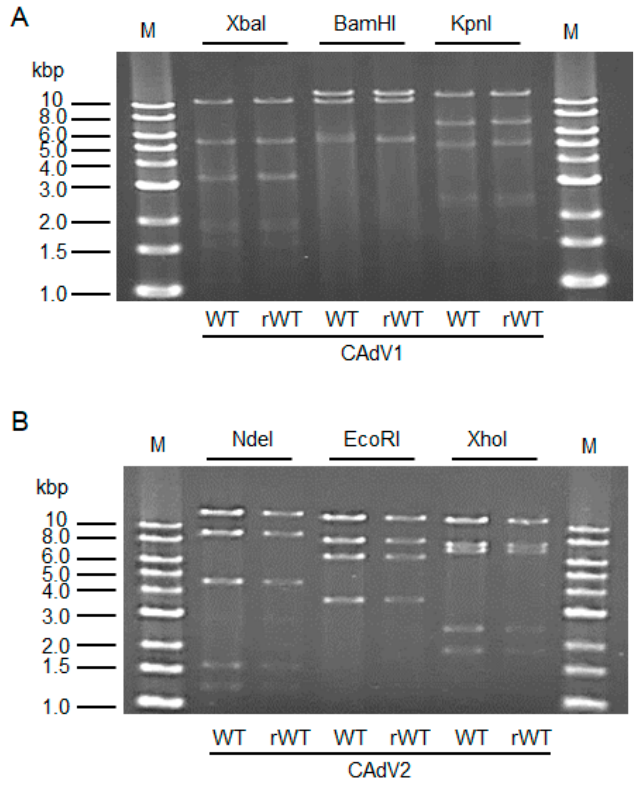
Figure 2. Restriction enzyme analysis of the genomes of wild-type (WT) and recombinant wild-type (rWT) viruses. ( A ) The genomes of CAdV1-WT and CAdV1-rWT were digested with XbaI, BamHI, and KpnI. The predicted molecular weights of the digested fragments of the viral genomes are 11250, 5551, 3383, 3301, 1955, 1834, 1587, 775, 519, 333, and 45 bp for XbaI; 13554, 10982, 5534, and 463 bp for BamHI; and 12573, 7077, 5110, 2490, 2302, and 981 bp for KpnI. M: 1-kb DNA ladder marker. ( B ) The genomes of CAdV2-WT and CAdV2-rWT were digested with NdeI, EcoRI, and XhoI. The predicted molecular weights of the digested fragments of the viral genomes are 14820, 9059, 4585, 1603, and 1253 bp for NdeI; 13014, 8192, 6504, and 3610 bp for EcoRI; and 12194, 7688, 7089, 2462, and 1887 bp for XhoI. M: 1-kb DNA ladder marker.